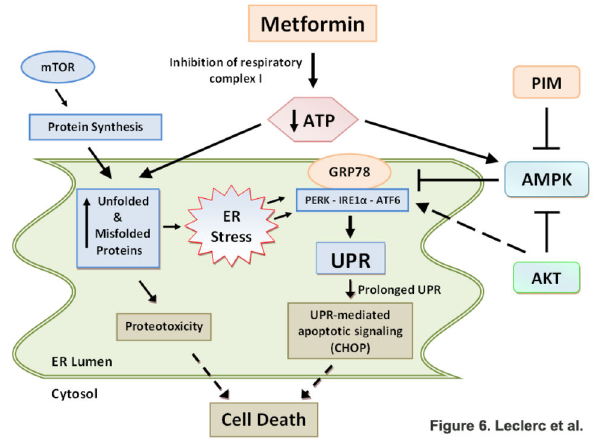
Figure 6. Proposed mechanism of action for metformin in ALL cells. Metformin induces metabolic stress by decreasing the ATP: AMP ratio, which leads to activation of AMPK, and increased level of unfolded/misfolded proteins in the ER